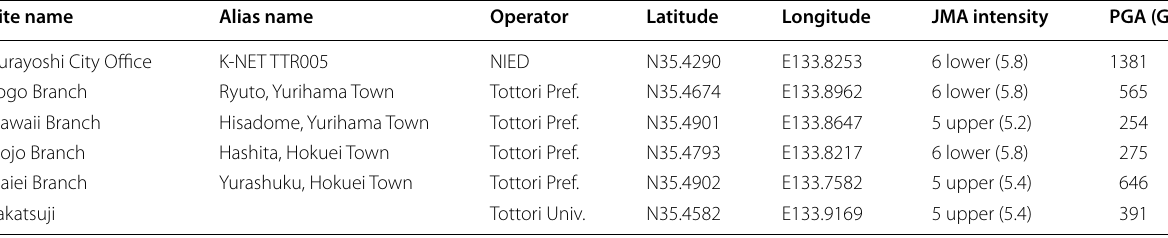
Table 1 Site information and characteristic values of the main